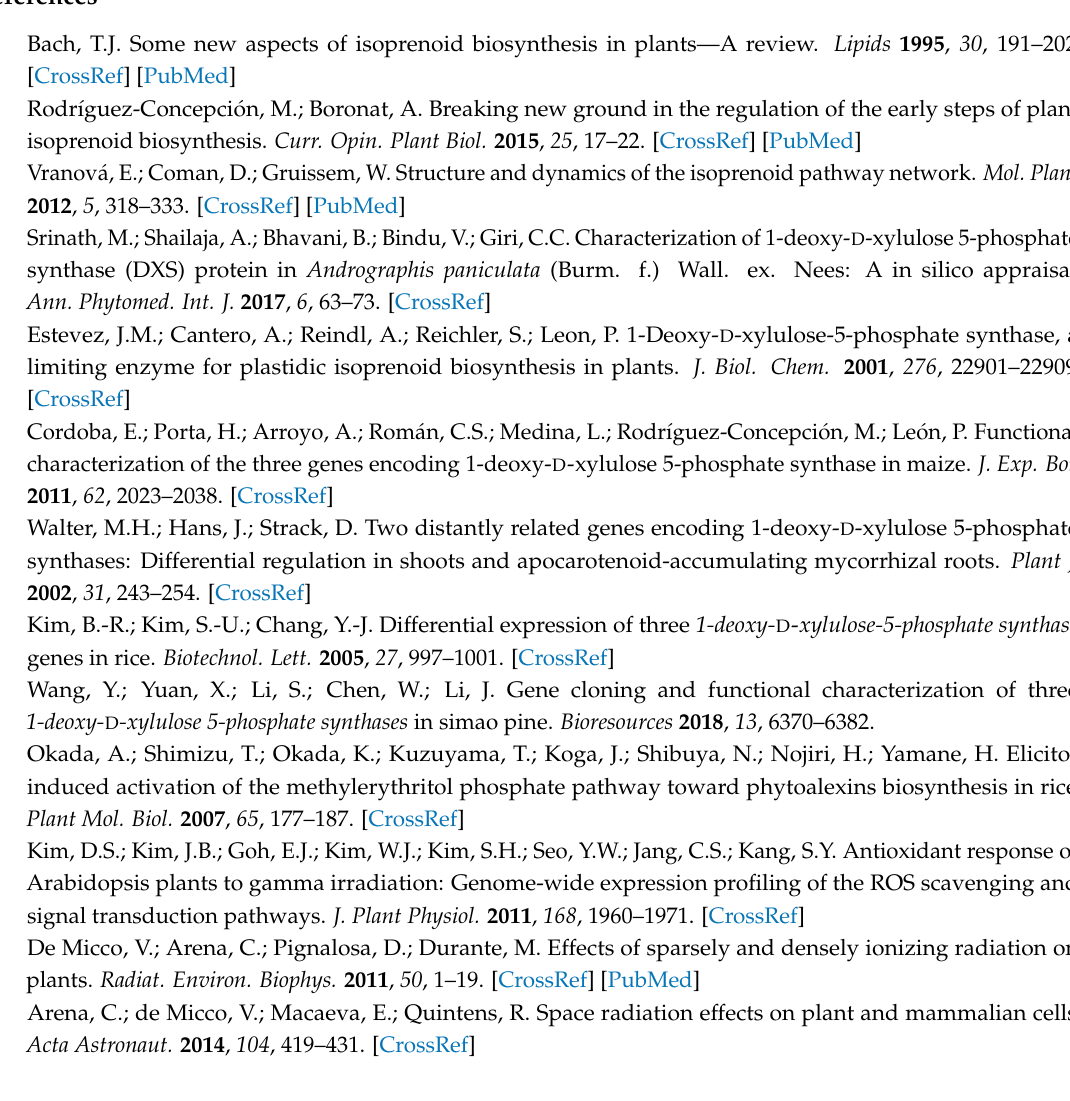
Table S1. The complete sequences of PpDXS1 promoter isolated from WT and A16. Table S2. Analysis of cis-acting regulatory element in PpDXS1 promoter and putative transcription factor binding to PpDXS1 promoter predicted by PlantCARE, TRANSFAC and JASPAR2016 online database. Table S3. List of various primers and their uses. Table S4. Detected copy results of GUS gene of transgenic lines. Figure S1. GUS histochemical staining of transgenic lines, including DXSpro_WT, DXSpro_A16, pCAMBIA1301 control. Figure S2. The result of interaction between other segment of PpDXS1 promoter region and transcription factor in yeast one hybrid